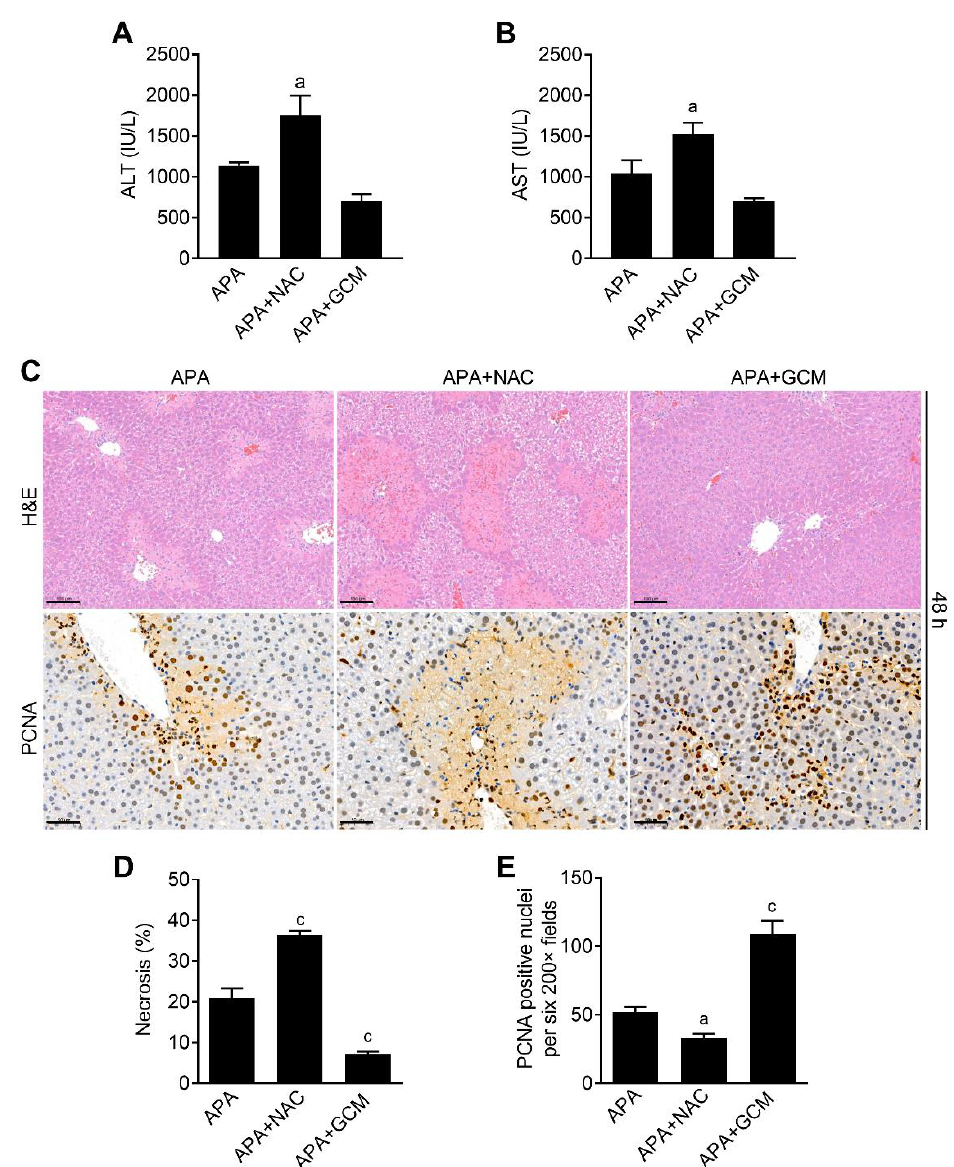
Figure 7. Prolonged treatment with glycycoumarin (GCM) facilitates liver recovery from APA hepatotoxicity. Animals were treated with 300mg/kg of APA followed by 100mg/kg of GCM or 100 mg/kg of NAC at 6, 12, 24 and 36 h after APA, and the blood and livers were harvested for analysis 48 h after the APA overdose. ( A ) The serum ALT and ( B ) AST levels and ( C ) histological characterization (upper panel, scale bar = 100 µ m) and IHC staining for PCNA (lower panel, scale bar = 50 µ m) in liver sections at 72 h were evaluated. ( D ) The percentage of hepatic necrosis areas and ( E ) PCNA-positive hepatocytes per photomicrographs were also quantified. Quantitative data are presented as the mean ± SEM. a: p < 0.05, c: p < 0.001 compared with the APA group.